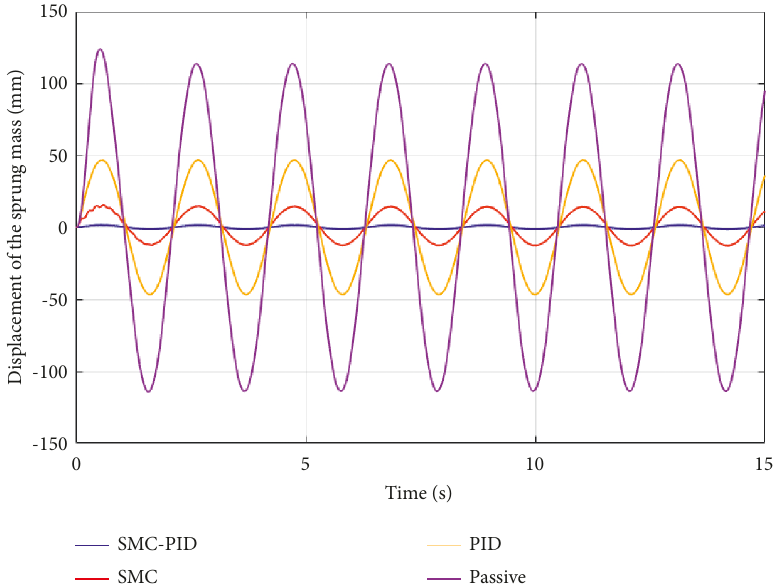
Figure 8: Displacement of the sprung mass (Case 2).